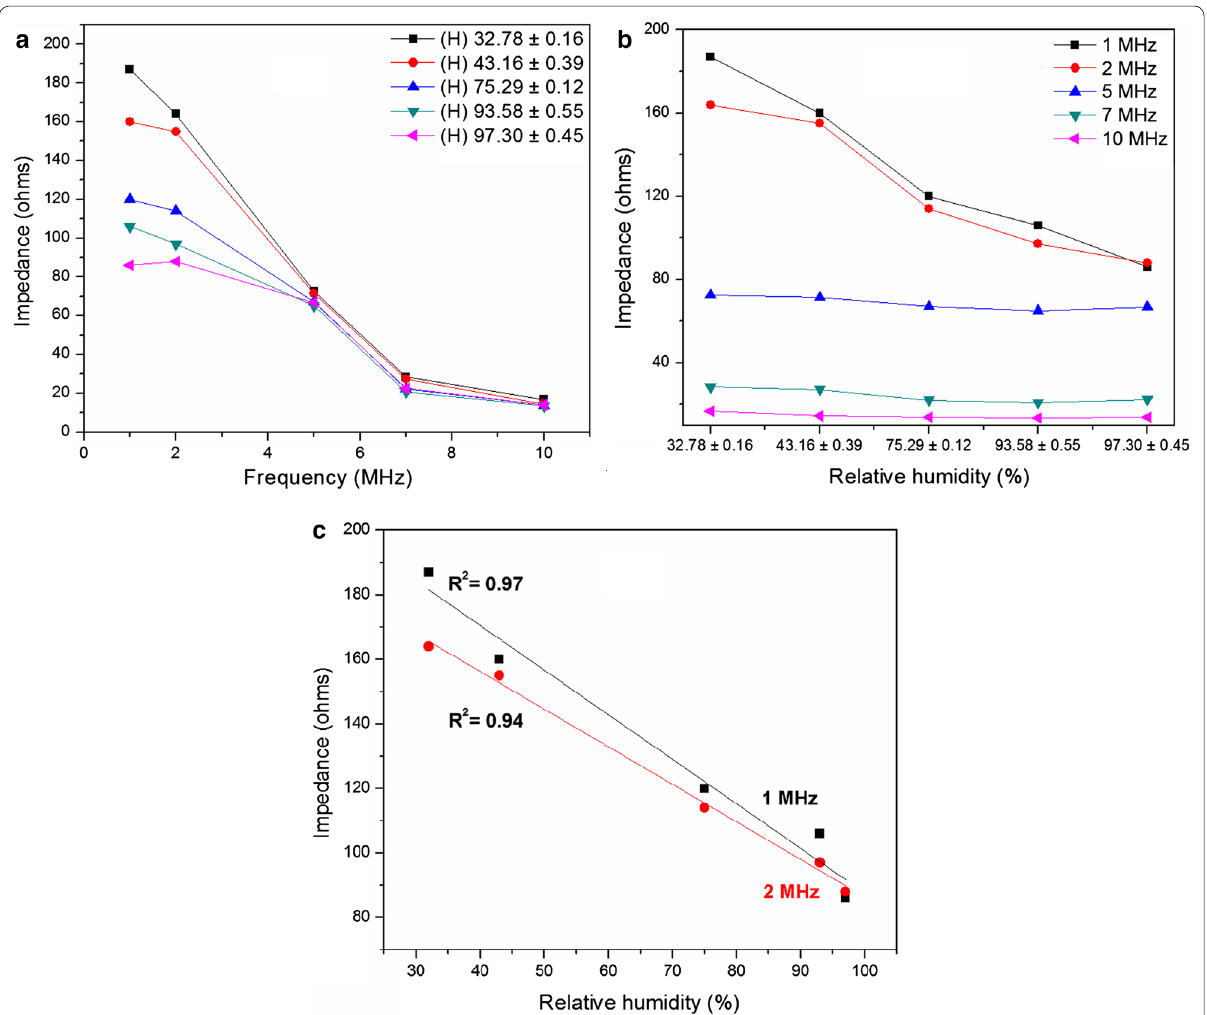
Fig. 12 a Impedance vs frequency, b impedance vs relative humidity in 1–10 MHz frequency domain for Pd incorporated PAni films and c linear curve fit at 1 MHz and 2